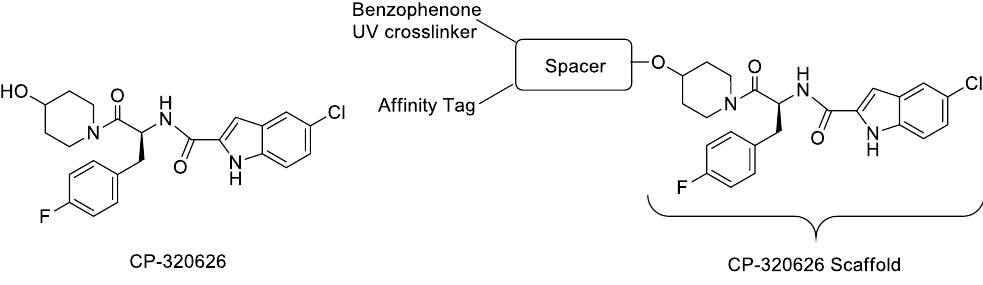
Figure 1. Our design strategy for photoaffinity probes.